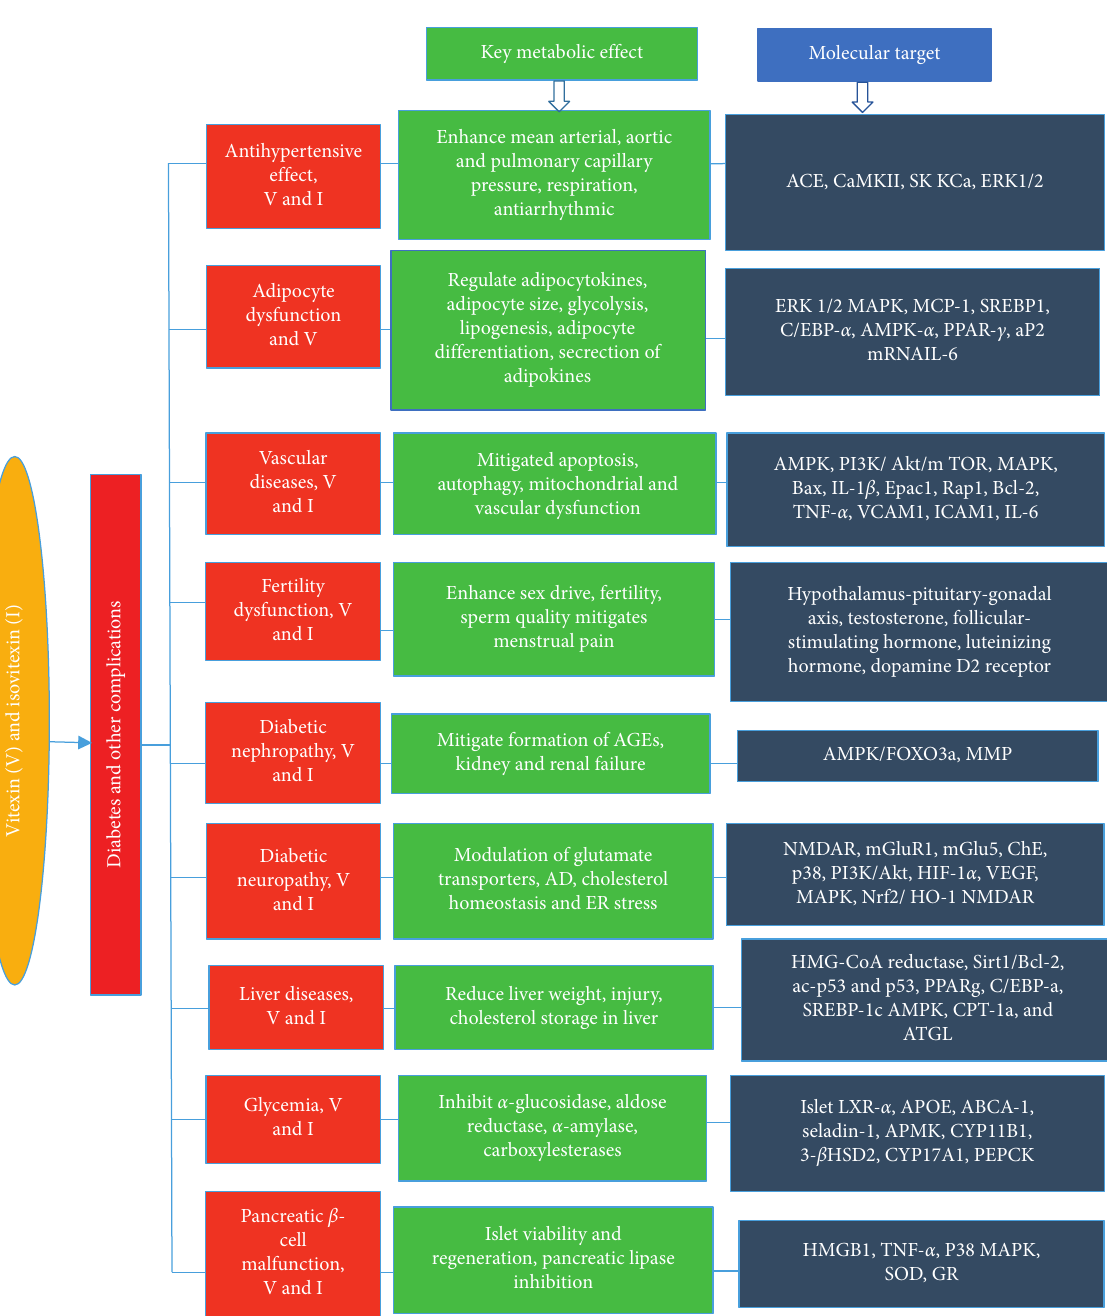
Figure 3: Schematic diagram of metabolic effects and molecular targets of vitexin and isovitexin in diabetes mellitus and its complication. V, vitexin; I,